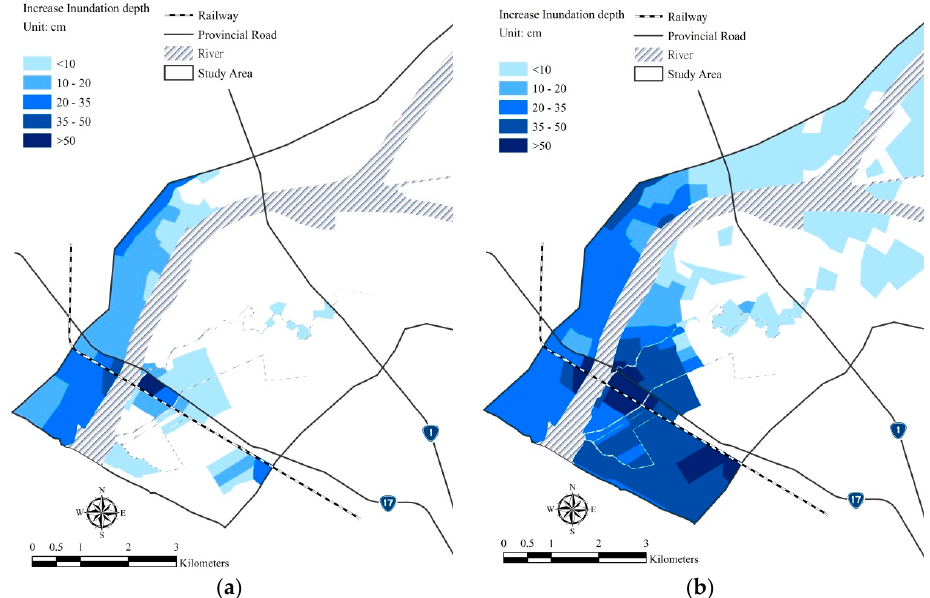
Figure 10. ( a ) Spatial distribution of inundation depth increase after land subsidence for a two-day storm under a 50-year return period; ( b ) Spatial distribution of inundation depth increase after land subsidence combined with climate change for a two-day storm under a 50-year return period. Land subsidence does not only increase inundation depth but also weakens the functioning of existing drainage systems. To understand the influence of land subsidence and land subsidence combined with climate change on flooding duration, the average flooding duration of each computational cell in the land subsidence area (Provincial Highway No. 1 to river outlet boundary), alone and with the influence of climate change, for each return period, was calculated by the area- ratio-weighted average method. The average flooding duration r ad can be expressed as: